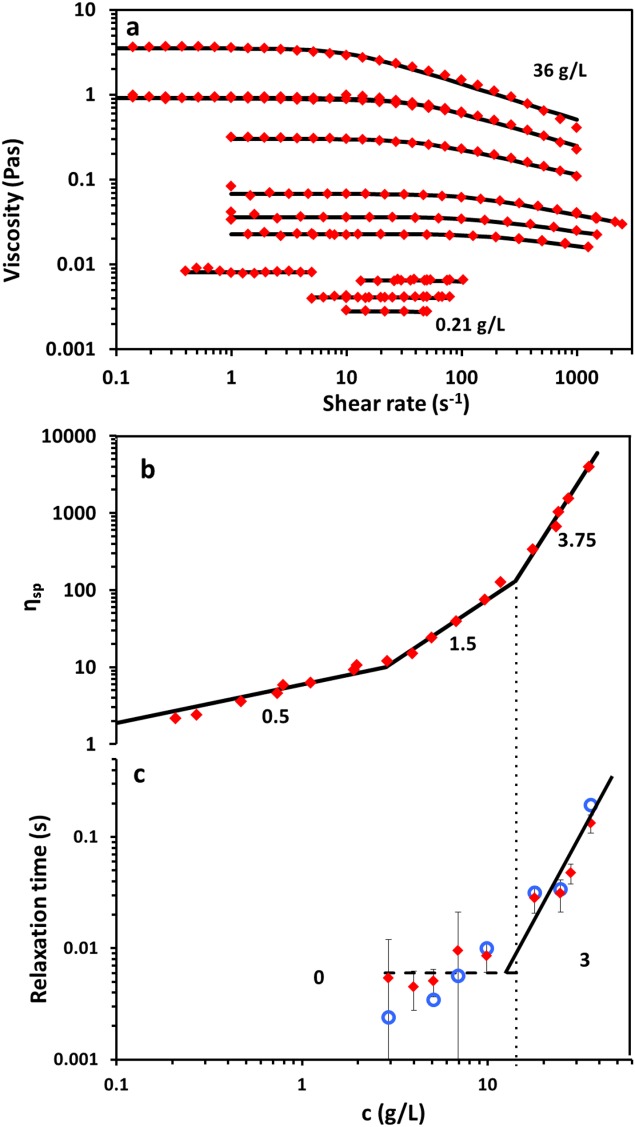
Rheology of NaCMC aqueous solutions. (a) Representative rheograms for c = 0.21 to 36 g/L, (b) specific viscosity as a function of concentration. The lines indicate the scaling predictions for the semidilute unentangled, semidilute entangled and concentrated power laws. c) Relaxation times (τ) as a function of concentration, red ♦ from Carreau model and blue • from shear rate at which viscosity is equal to 90% of its zero shear value. Lines indicate power laws of 0 and 3. The dotted vertical line indicates cD = 14.4g/L. [Color figure can be viewed in the online issue, which is available at http://wileyonlinelibrary.com.]